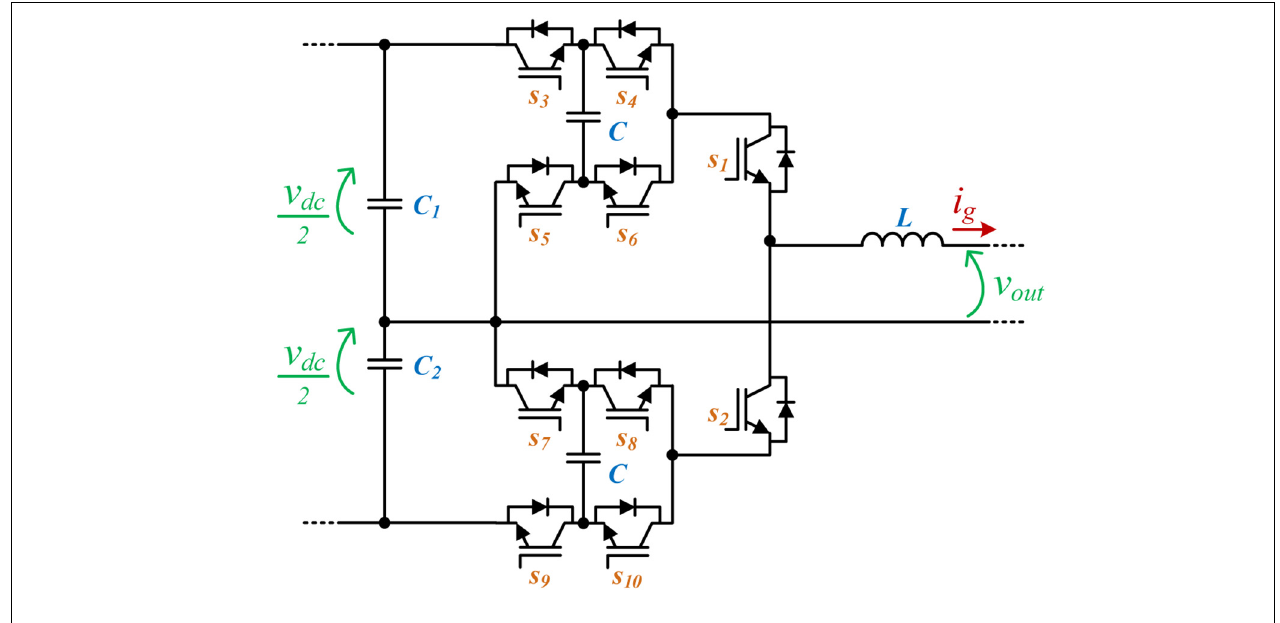
FIGURE 9 | Topology proposed in Naderi et al.